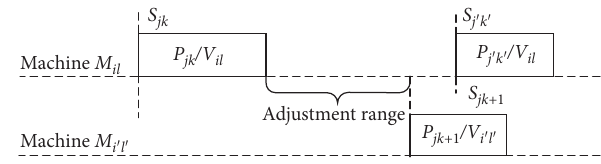
Figure 9: Adjustment diagram when S